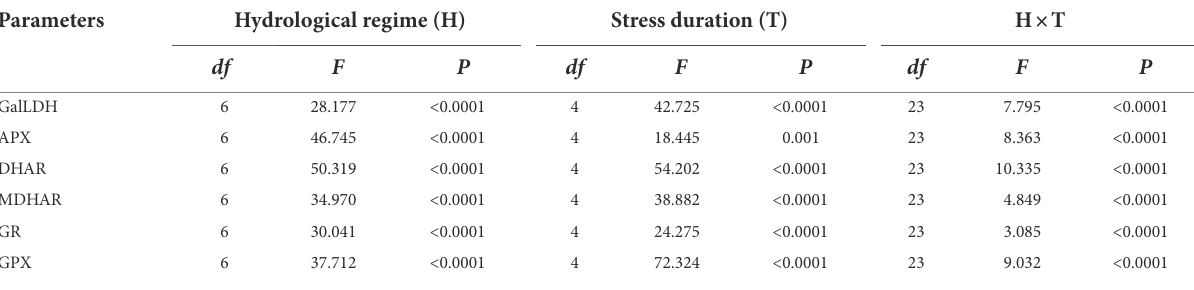
TABLE 4 Results of linear mixed models examining the effects of hydrological regime, stress duration and their interactions on the critical enzyme activities in AsA-GSH cycle of hairgrass ( Deschampsia caespitosa ). Parameters Hydrological regime (H) Stress duration